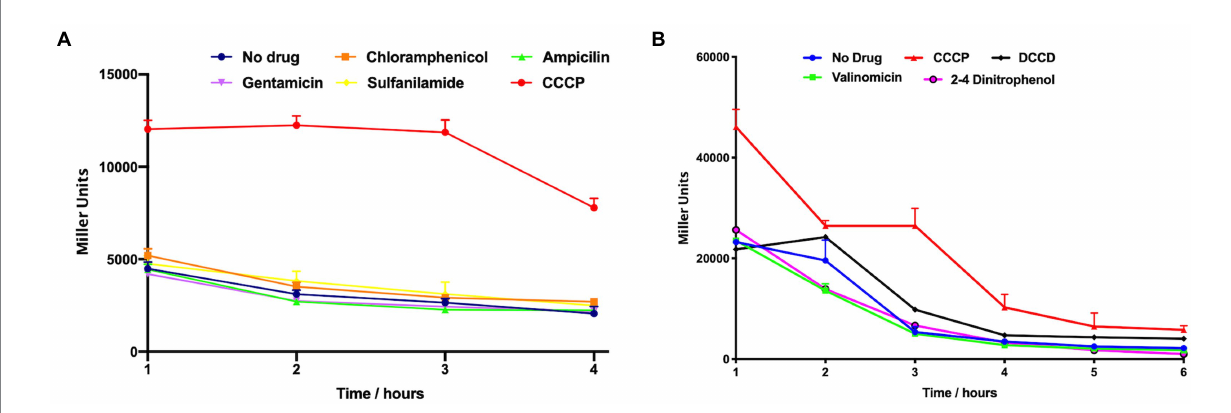
FIGURE 1 P amsSR transcription is induced upon exposure to the protonophore CCCP. ß-galactosidase activity of an amsSR - lacZ fusion strain was measured hourly during exposure to the agents shown. Transcriptional activity is expressed as Miller Units. Data is derived from three independent biological replicates, with panels (A) and (B) generated from separate experiments. Error bars ±